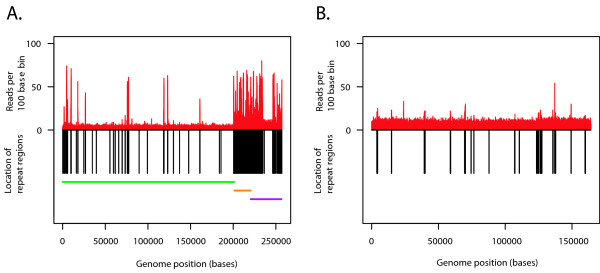
A & B: Comparison of control sequence coverage versus repeat region location. Distribution of sequence coverage from unamplified control Halobacterium species NRC-1 population as determined by sequence based karyotyping at 100 base resolution relative to repeat region and chromosome location. A. Counts per bin are displayed above the X axis in red, repeat regions are shown below the X axis in black. The X axis displays the length of the genome in bases. The relative location of the three Halobacterium chromosomes are shown by the horizontal bars below the X axis, NRC1 is green, pNRC100 is gold, and pNRC200 is purple. B. As for Figure 3A, but for Campylobacter jejuni. No chromosome bars are included as C. jejuni is comprised of a single chromosome.